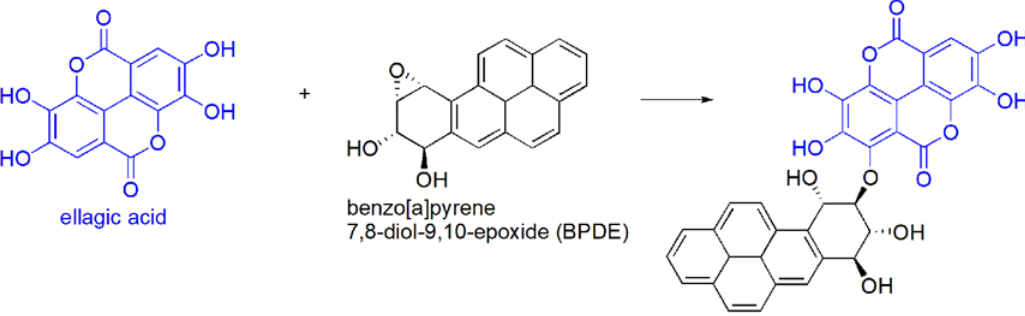
Figure 4. In vivo EA formation and metabolism.